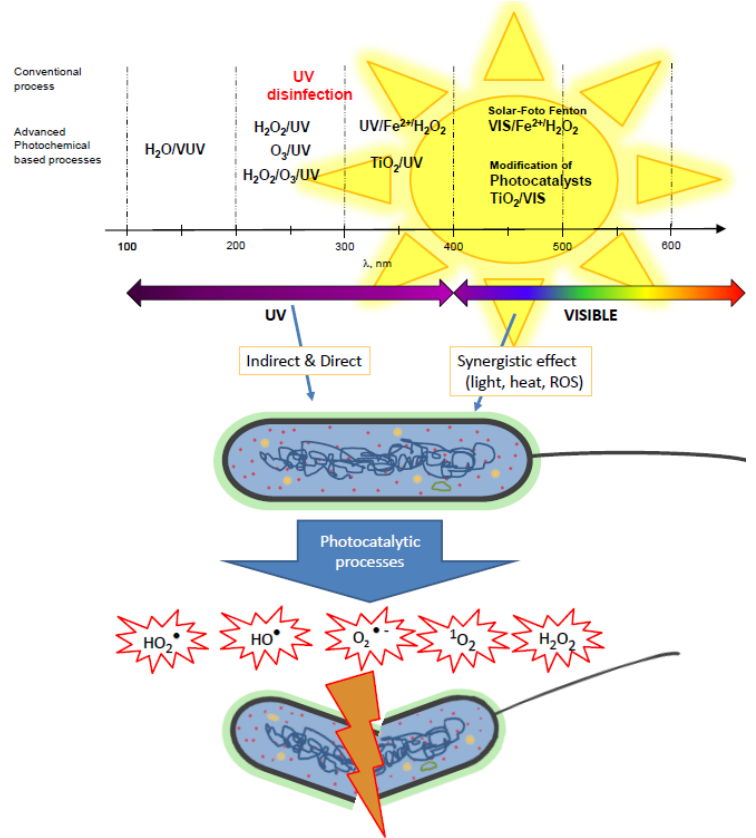
Figure 1. The schematic range of electromagnetic radiation used in photochemical disinfection processes and its effects on patogens (based on [35,51,69–75]).